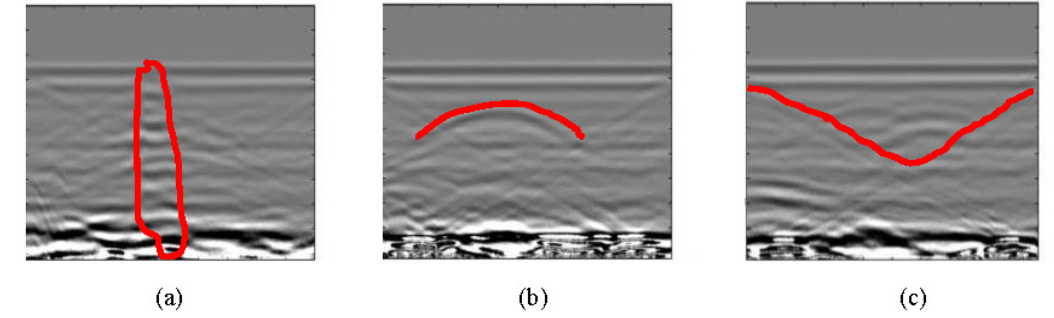
Figure 2. Identifiable forms in raw images in Sections 3.1 and 3.2: ( a ) distorting vertical strip; ( b ) hyperbola; ( c )